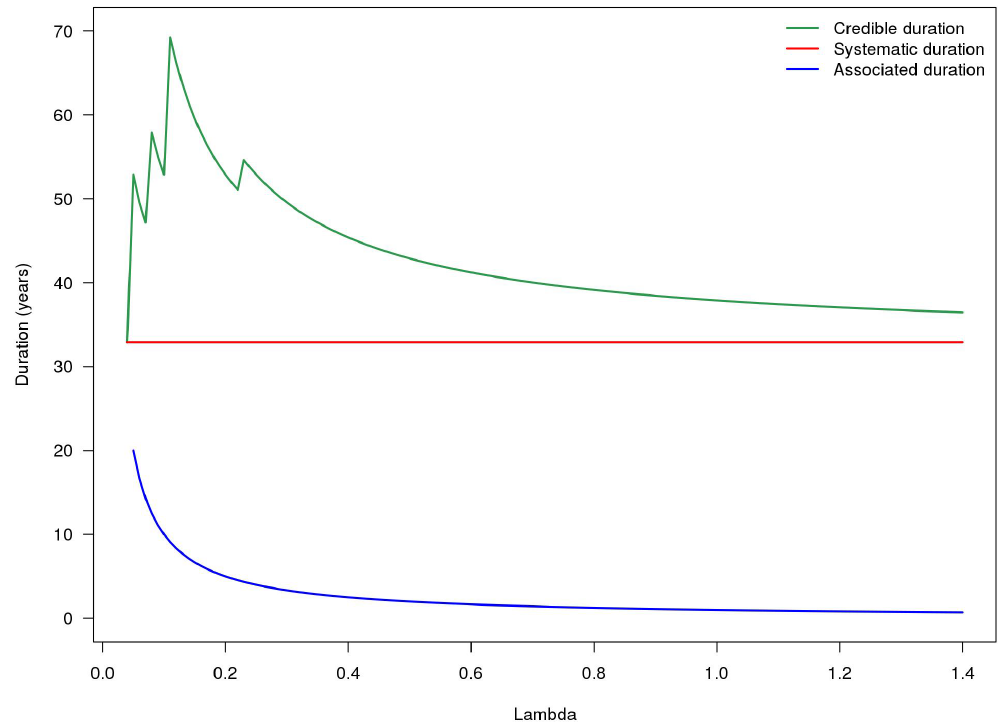
Figure 3. Fictive example of skew surge dataset of systematic and historical data – Credible duration (green line), systematic duration (red line) and associated duration (blue line) for several threshold